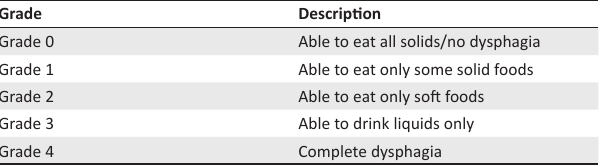
TABLE 1-A1: Dysphagia score grading